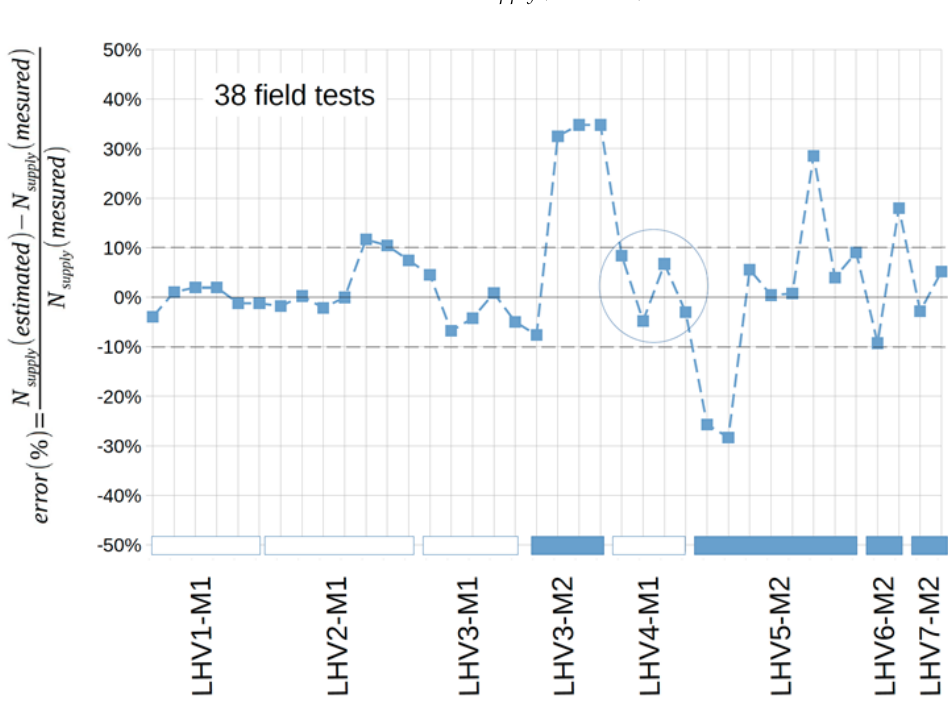
Figure 16. Bounds of the power estimation errors of the applied method.